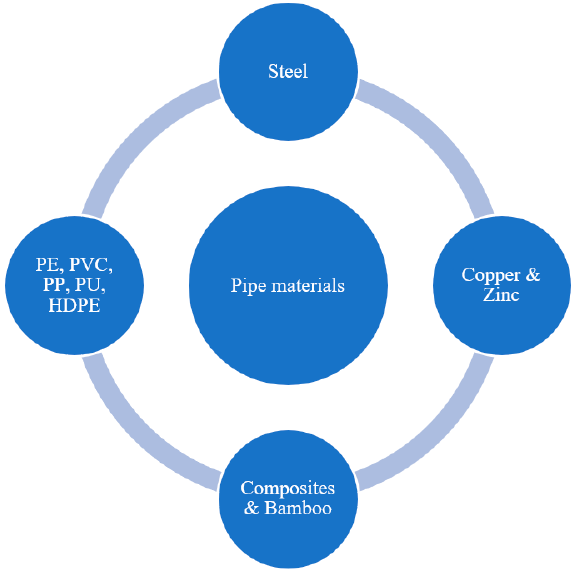
Figure 2. Variety of materials used in Pipes.